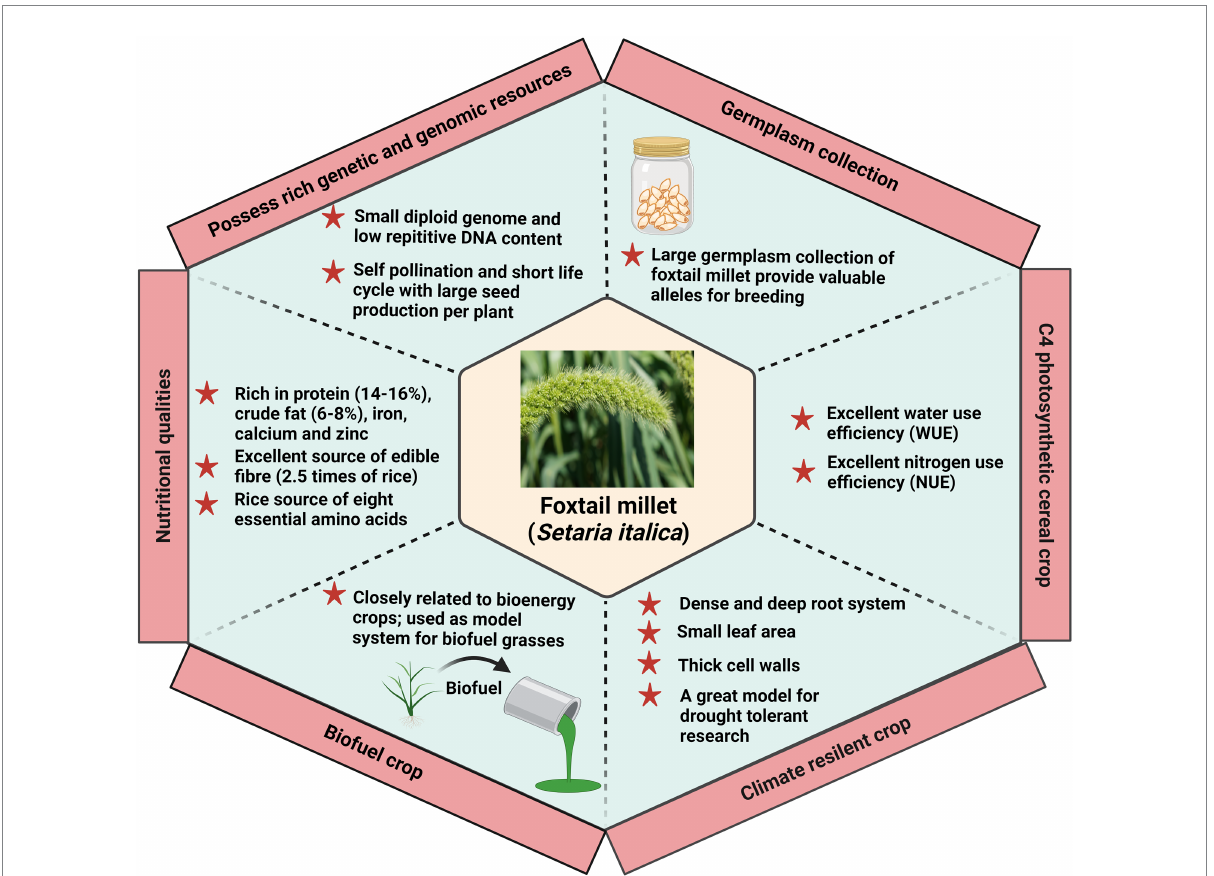
FIGURE 4 Foxtail millet as a model crop to translate the information in other crops. Foxtail millet is considered an ideal model system due to its physiological, genetic, and climate resilience